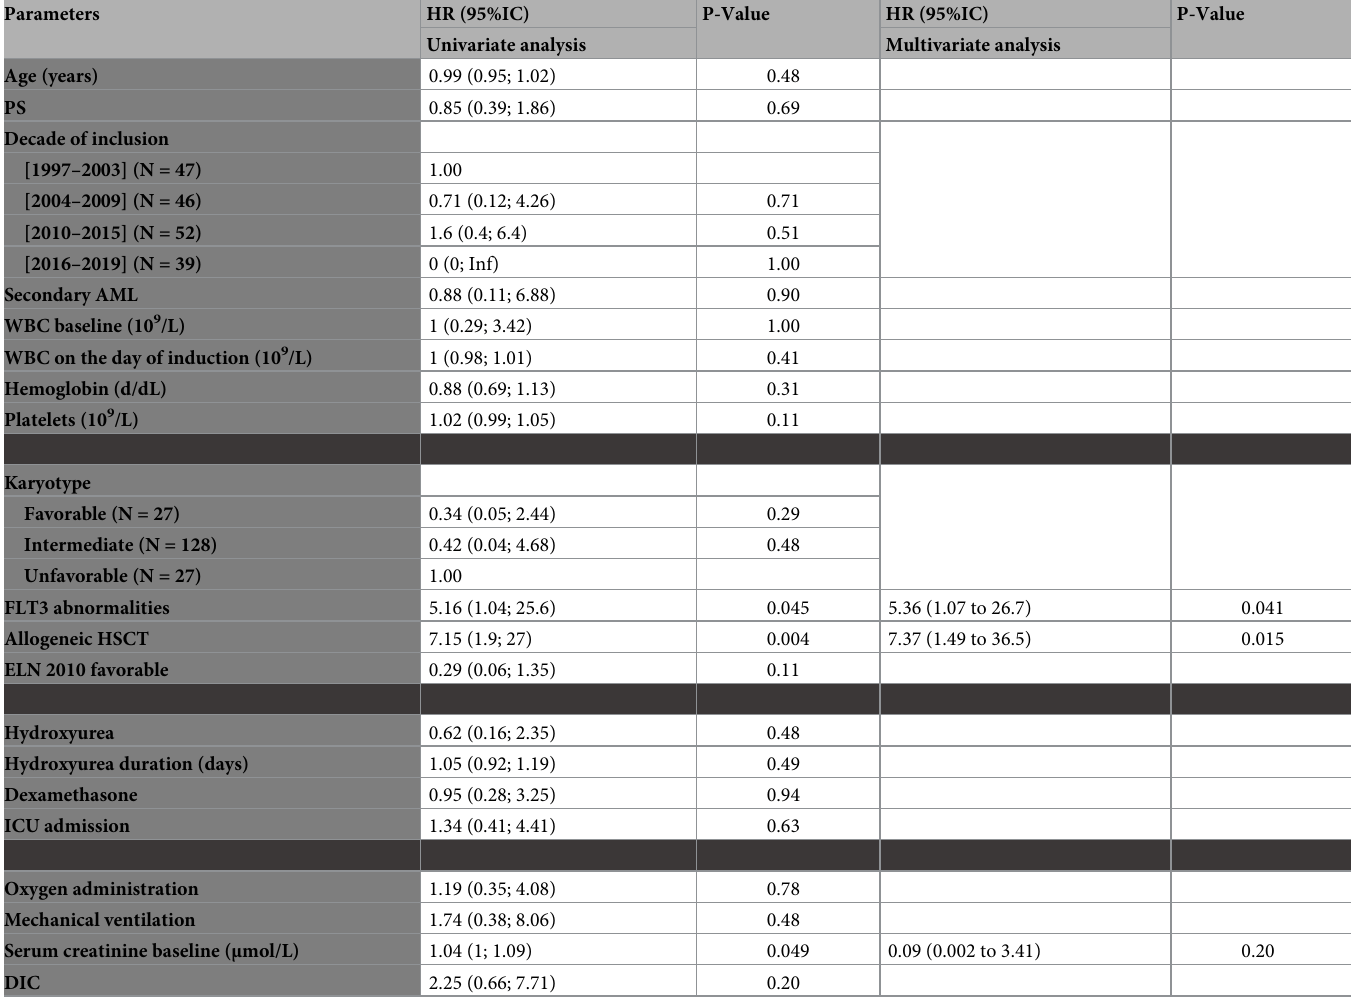
Table 3. Univariate and multivariate analysis of treatment-related